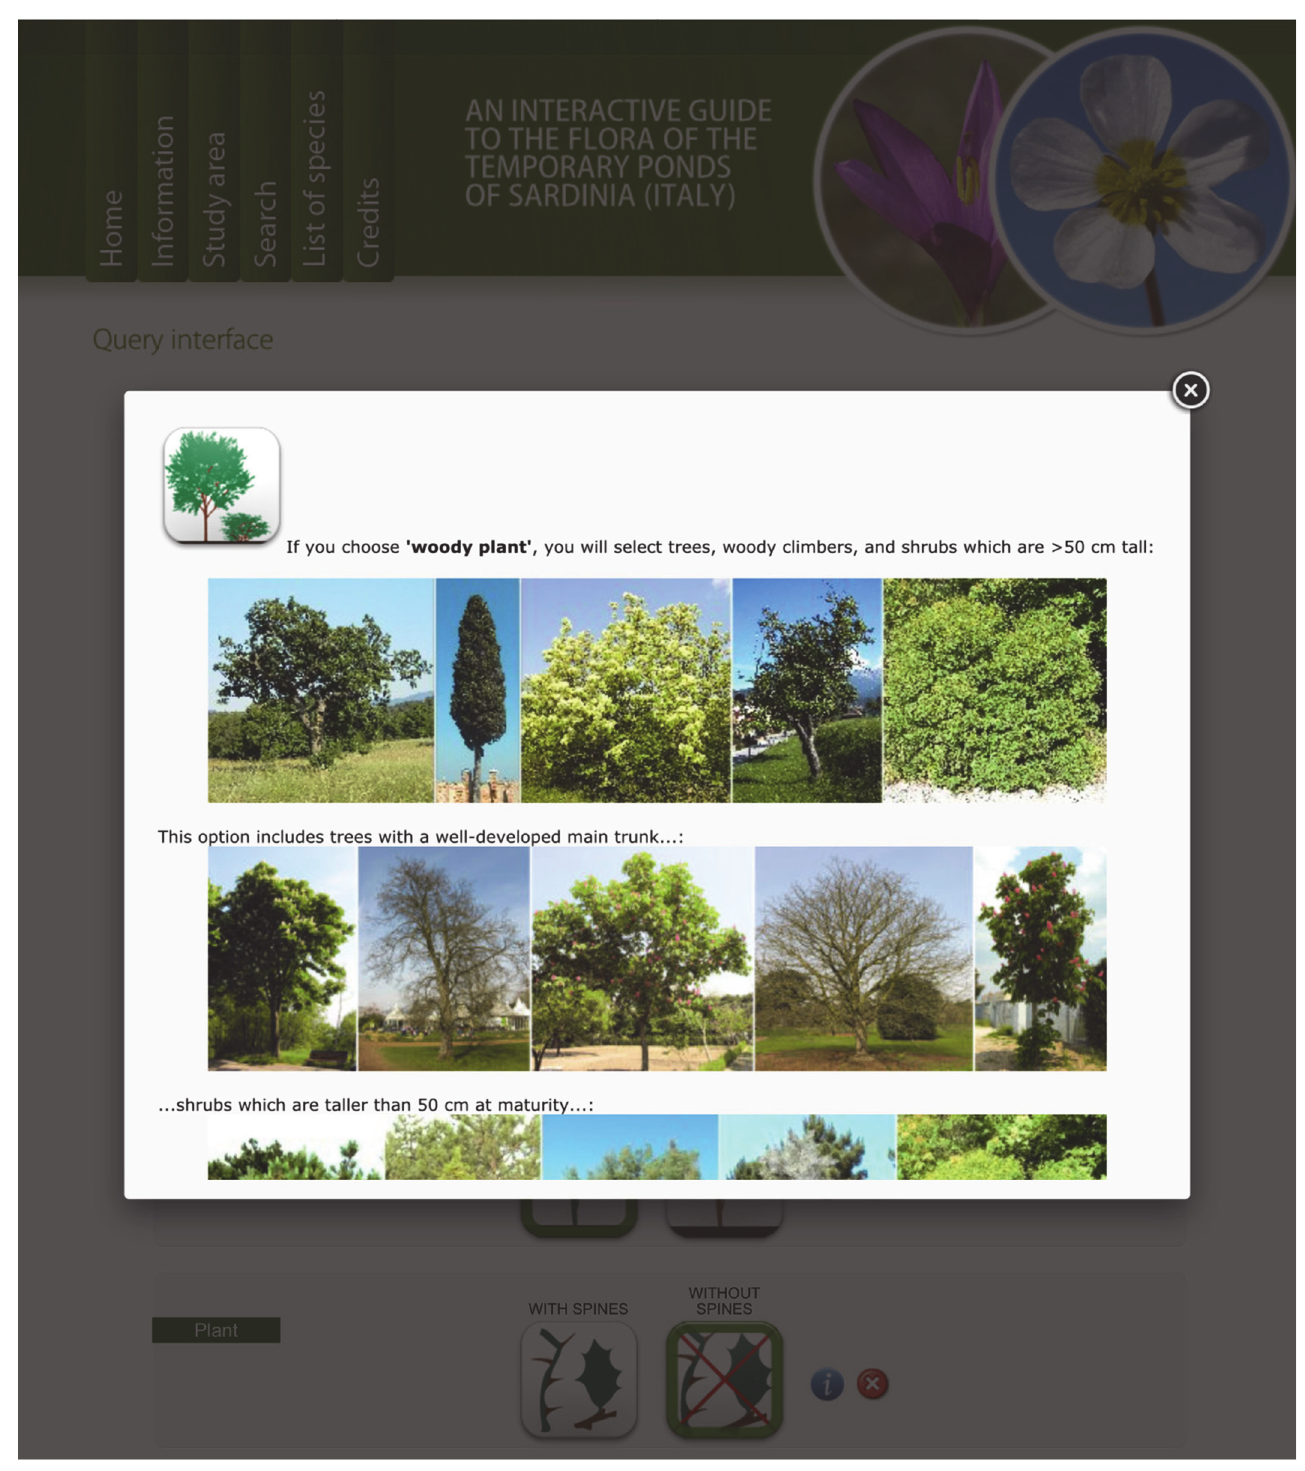
Fig 5. Popup window with information on a